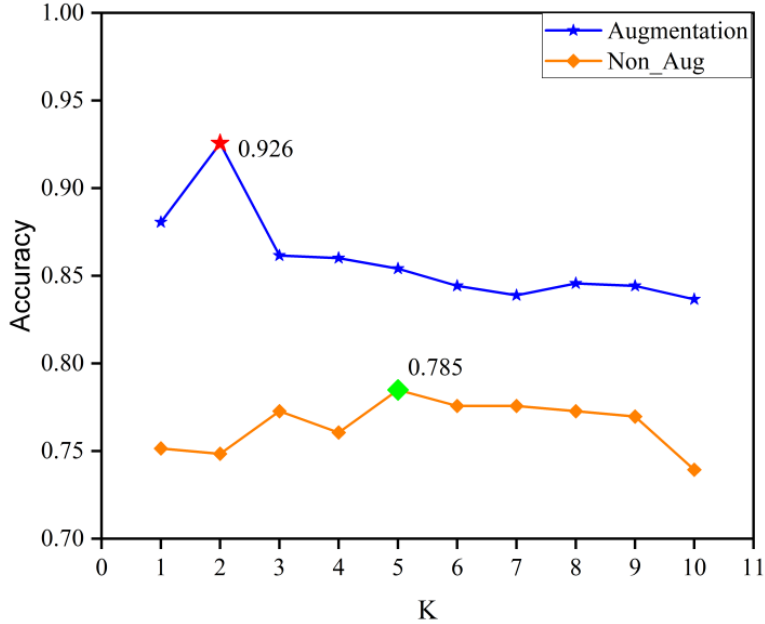
Figure 11. The a accuracy of the KNN algorithm. For GA_SVM, as Figure 6 shows, we need to build a population of several individuals that include two gene sequences of a particular length or a chromosome. The population produces offspring through a certain probability of breeding and gene mutation. Then, the binary code of each offspring individual is used to represent the C and g in a given interval. Thus, many different SVM models are generated, and we constantly repopulate and select until finding the optimal one (also optimal C and g ). Here, the objective function of the GA is the MSE (Equation (12)) value of a different model. Finally, GridSearch is used to search for a final result in a small range based on the optimal C and g values by GA. Table 5 provides the information of several parameter settings of the GA, including the iterations, population size, gene mutation probability, breeding probability, and the interval of penalty factor C and kernel function parameter g . As before, the training of each SVM classifier still uses the 10-fold cross-validation method. The classification accuracy of different values of C and g is visualized in Figure 12, and the maximum values of all metrics are presented in Table 4. Figure 12 shows that parameter C has a minimal influence on the accuracy. The accuracy has a trend of increasing and then decreasing with the variation of g while C keeps steady. The maximum value is 0.930 when C = 1.6 and g =